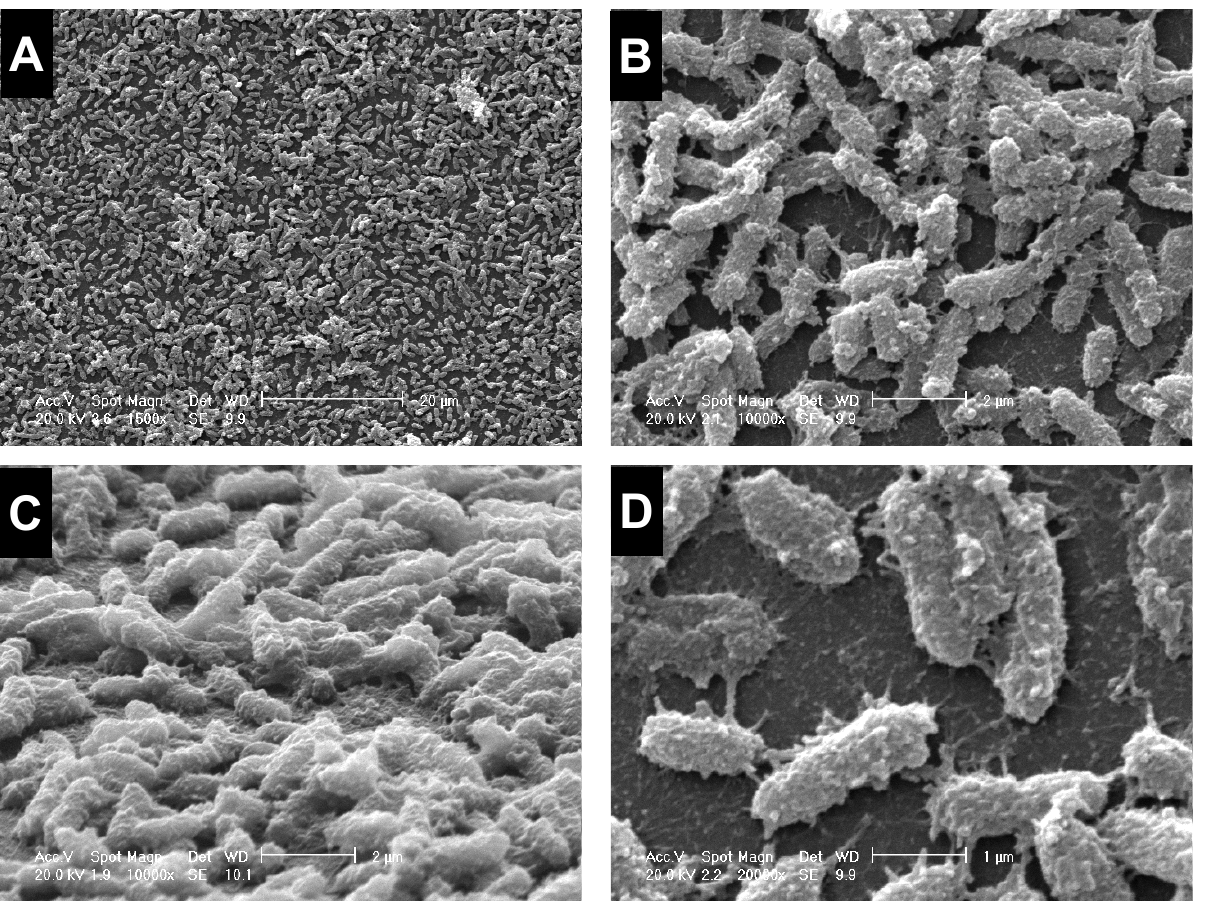
Figure 2. Scanning electron microscopy observation of S. maltophilia mature biofilm. The Sm126 strain was allowed to form biofilm onto 35-mm TC-treated polystyrene dishes for 24 h at 37 °C under static conditions. Magnifications: ×1.500 ( A ); ×10.000 ( B ); ×10.000 ( C ) (60°-inclined); ×20.000 ( D ).